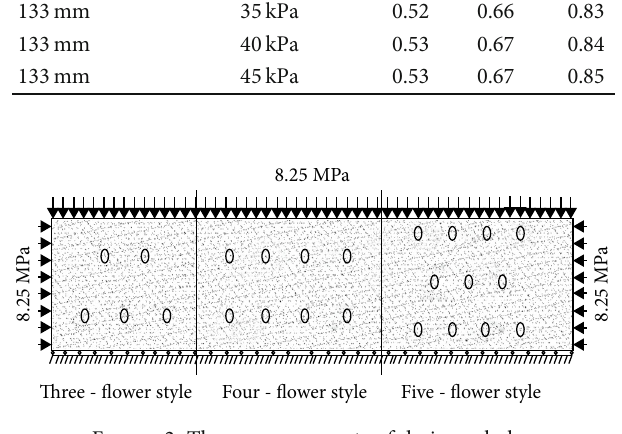
Figure 2: Three arrangements of drainage holes.